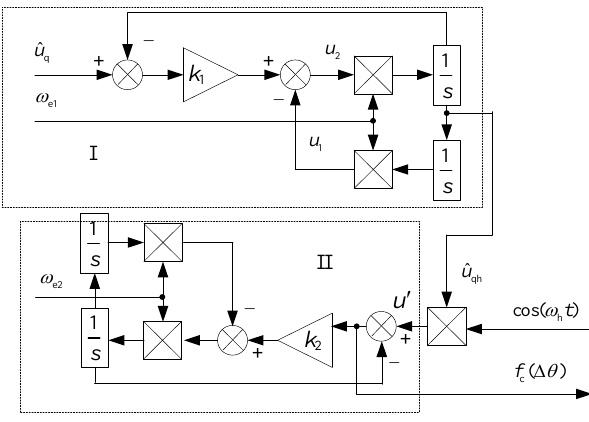
Figure 6. Principle of the improved position observer structure.